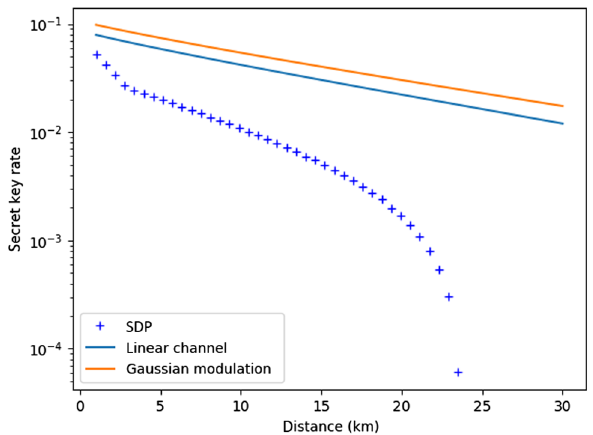
FIG. 4. Secret key rate versus distance, for a Gaussian channel with transmittance T ¼ 10 − 0 . 02 d and excess noise ξ ¼ 0 . 01 . Other parameters are the same as in Fig.